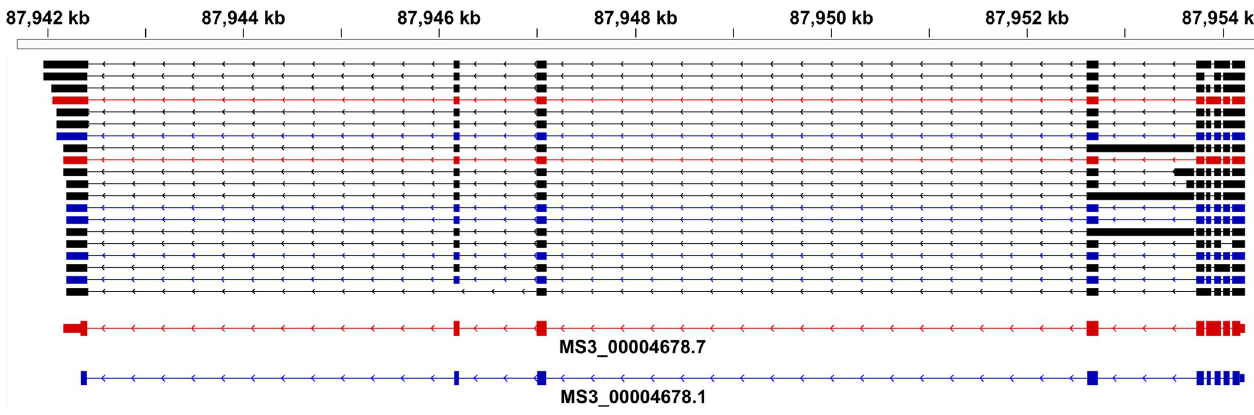
Fig 4. Long-read, full-length transcripts supporting differential isoform usage in male and female Schistosoma haematobium . The gene model MS3_00004678 encodes a small GTPase on chromosome ZW. Exons are depicted as blocks and introns as arrowed lines, indicating the coding strand. Reference transcripts are shown at the bottom in red (female; MS3_00004678.7, transcription cluster 7) and blue (male; MS3_00004678.1; transcription cluster 6) with narrow blocks at the end of the gene models representing untranslated regions (UTRs). Full-length, long-read transcripts that matched the intron-exon structure of the isoforms inferred to be transcribed in the male and female adult stage, respectively, are coloured accordingly. Transcripts that support distinct, alternative exon-intron boundaries are shown in black.